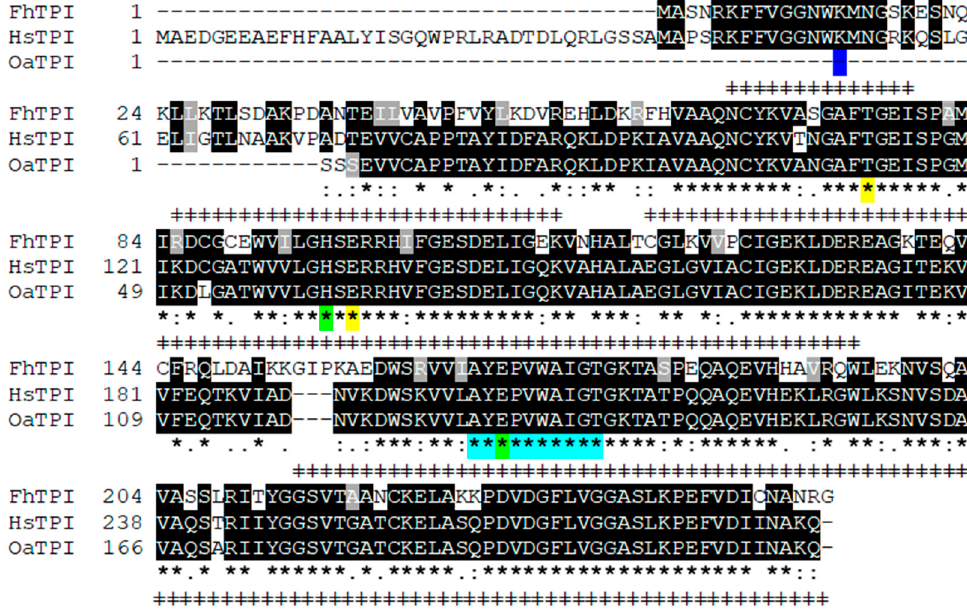
Figure A2. LC-MS/MS identification of FhTPI and comparison with host TPI proteins via sequence alignment. Sequence analysis of FhTPI is shown, including LC-MS/MS-identified residues ( ǂ : GenBank, AGJ83762.1) based on 2-DE and duplicate 1-DE separated proteins (Figure 3C,D) that matched 86.5% FhTPI residues (GenBank, AGJ83762.1). Alignment of FhTPI with human (P60174) and ovine (W5P5W9) host proteins was conducted to identify sequence identity of 68.6% for both. Putative residues involved in structural and functional roles were indicated based on matching to HsTPI [17–20], including the TPI active site (FhTPI, A-167-T-176), and residues for dimerization (FhTPI, T-76, E-98), catalysis (FhTPI, K-14), or both processes (FhTPI, H-86, E-169), residues that were completely conserved between all three sequences here. Abbreviations: *, conserved; strongly semi-conserved; weakly semi-conserved.